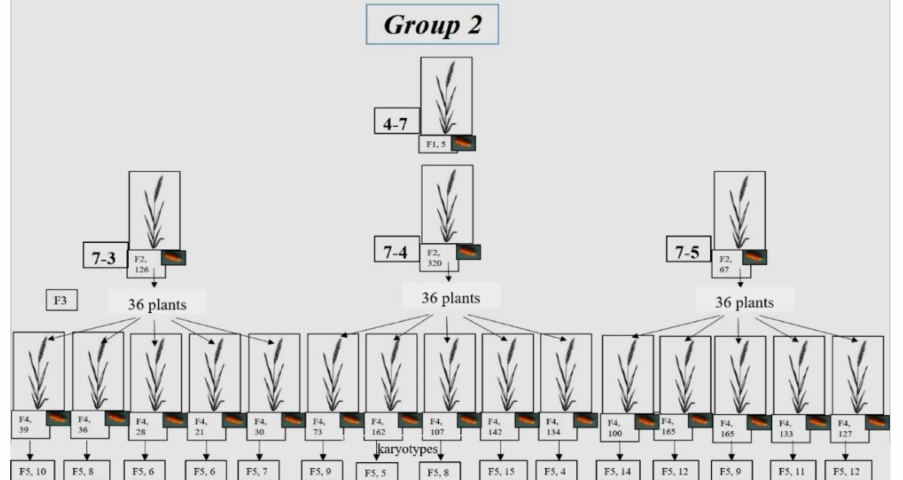
Figure 2. Development of wheat–rye hybrids of Group 2. The scheme shows individual plants of the F 1 –F 4 generations, and the number of seeds in these plants. In the F 5 generation, the number of plants analyzed for karyotype is